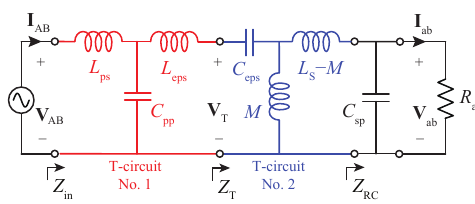
Figure 4. Equivalent circuit of Figure 3 for achieving constant voltage